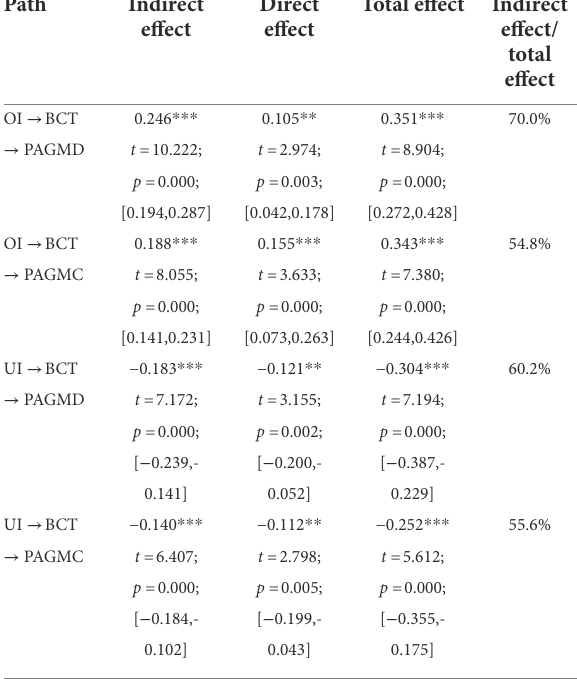
TABLE 7 Significance analysis of the mediation effects.